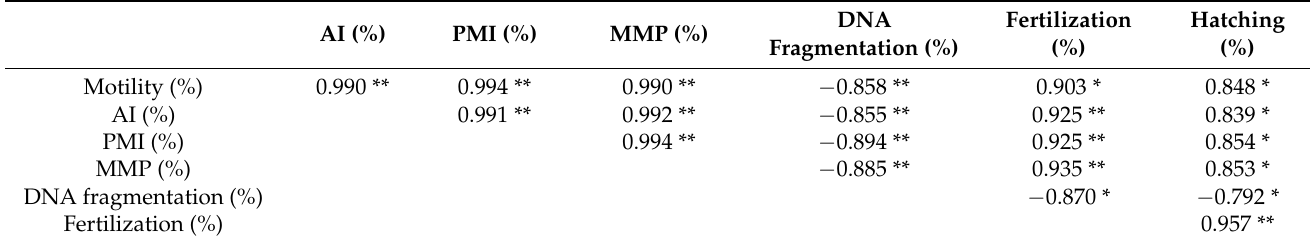
Table 2. Correlation coefficients ( r ) among sperm quality parameters of Pacific abalone, H. discus hannai